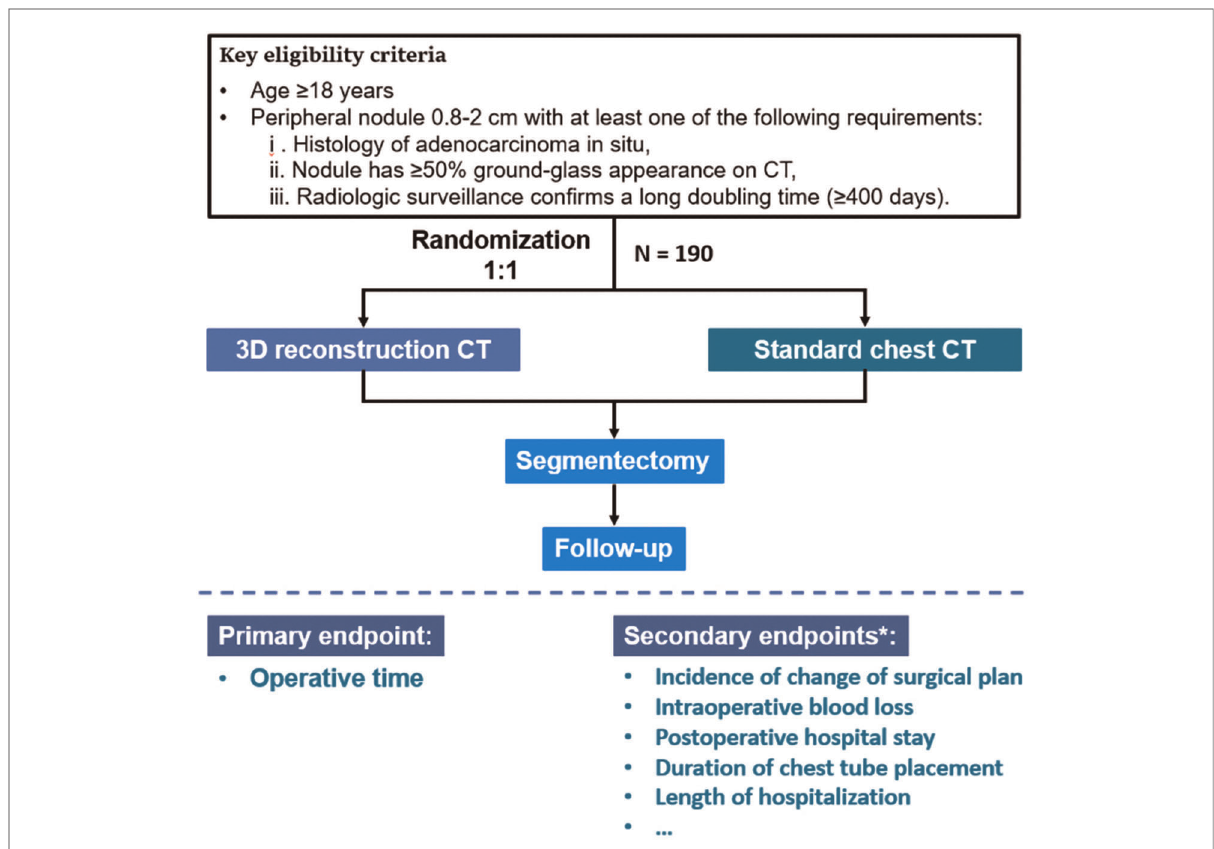
FIGURE 2 Trial design and fl ow chart of the DRIVATS study. *Details of the secondary endpoints are described in Materials and methods. CT, computed tomography; 3D,